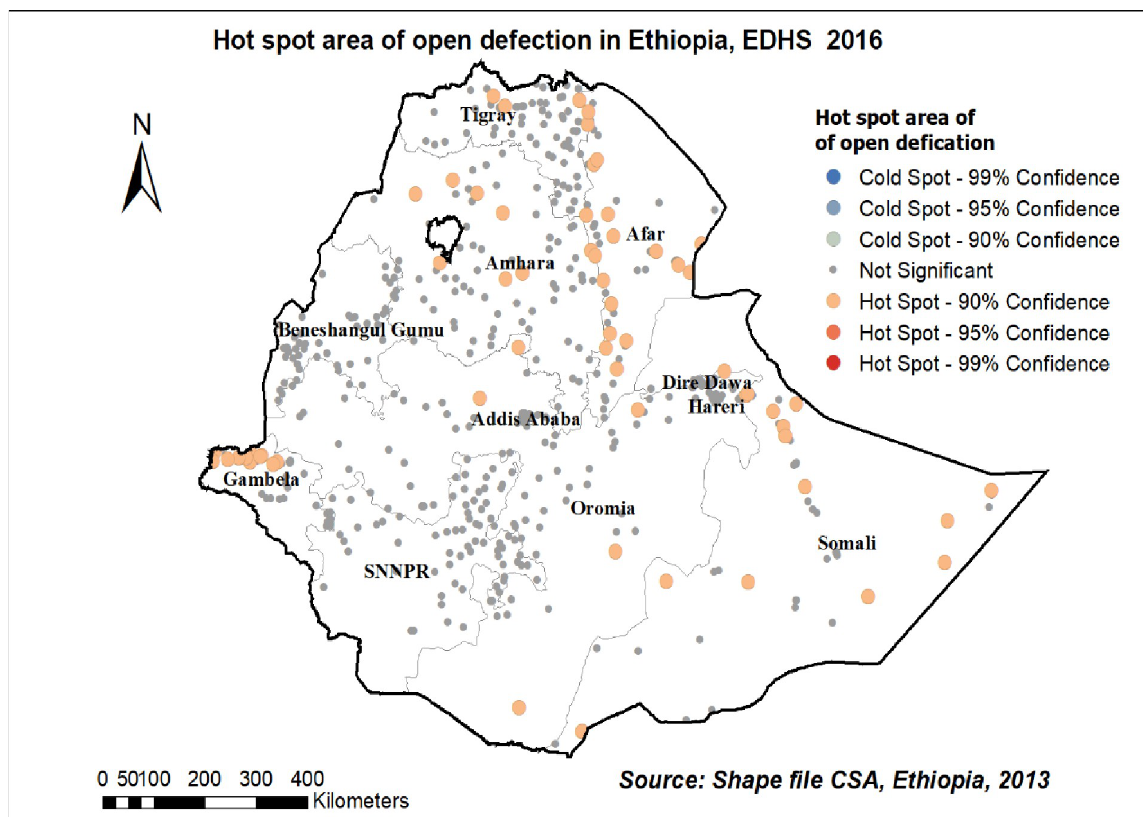
Fig 6. Hot spot area of open defecation in Ethiopia EDHS 2016 plotted using ArcMap 10.7.